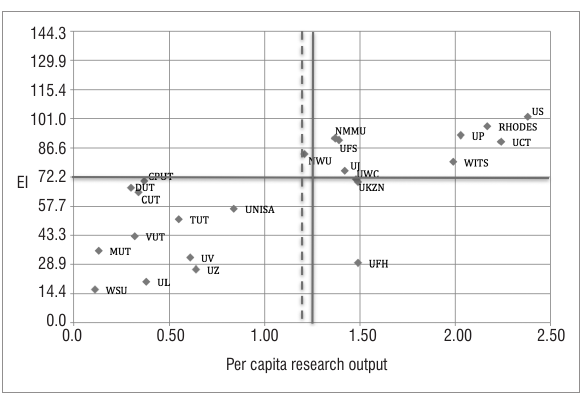
Figure 4: The 2011 per capita research output versus the instructional/ research professional staff Equity